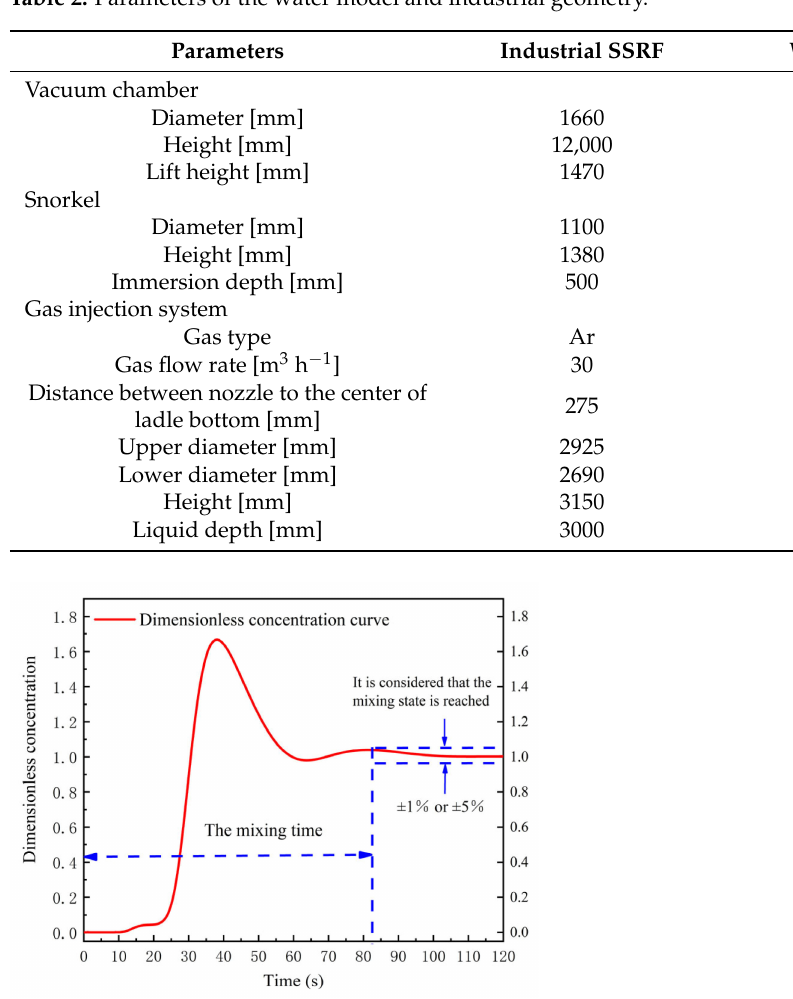
Table 2. Parameters of the water model and industrial geometry.